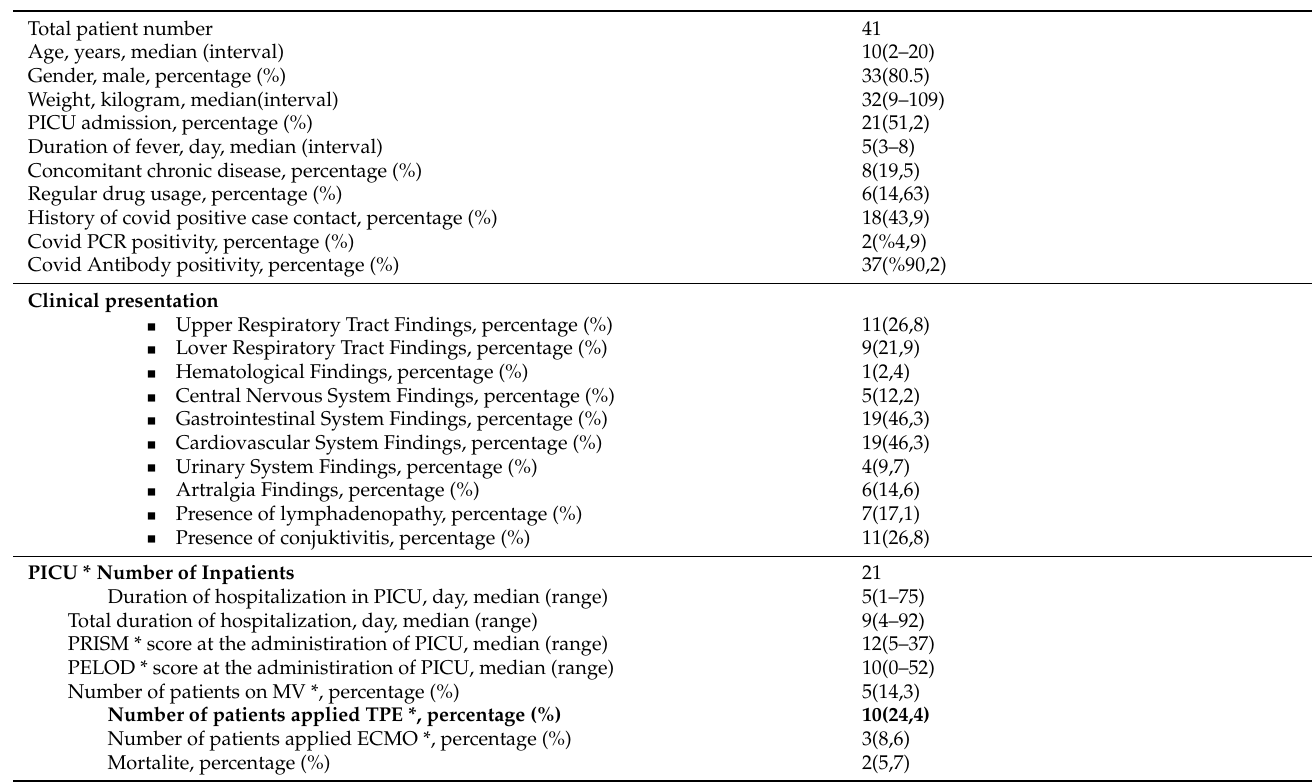
Table 1. Characteristics of Patients.